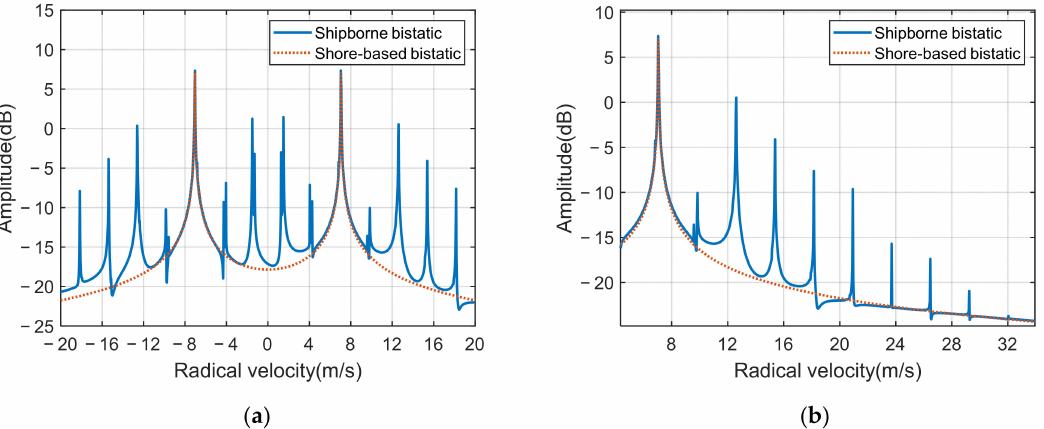
Figure 8. Simulated first-order Doppler spectra for oscillation motion (blue solid line) and motion-free (red dotted line). ( a ) First-order Doppler spectra of two systems. ( b ) Zoomed-in view of the positive Doppler spectra in ( a